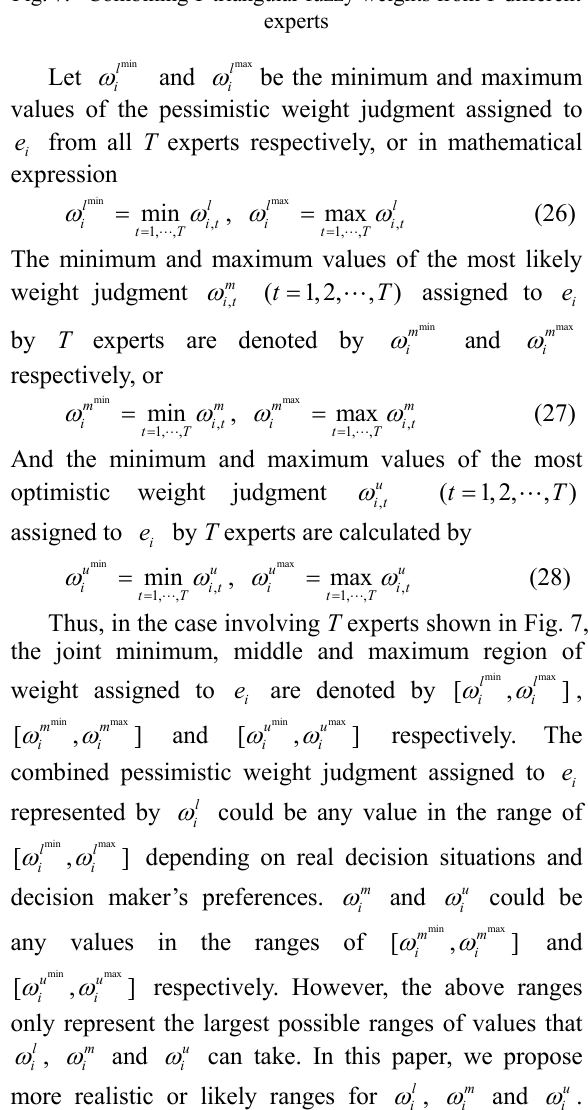
Fig. 7. Combining T triangular fuzzy weights from T different